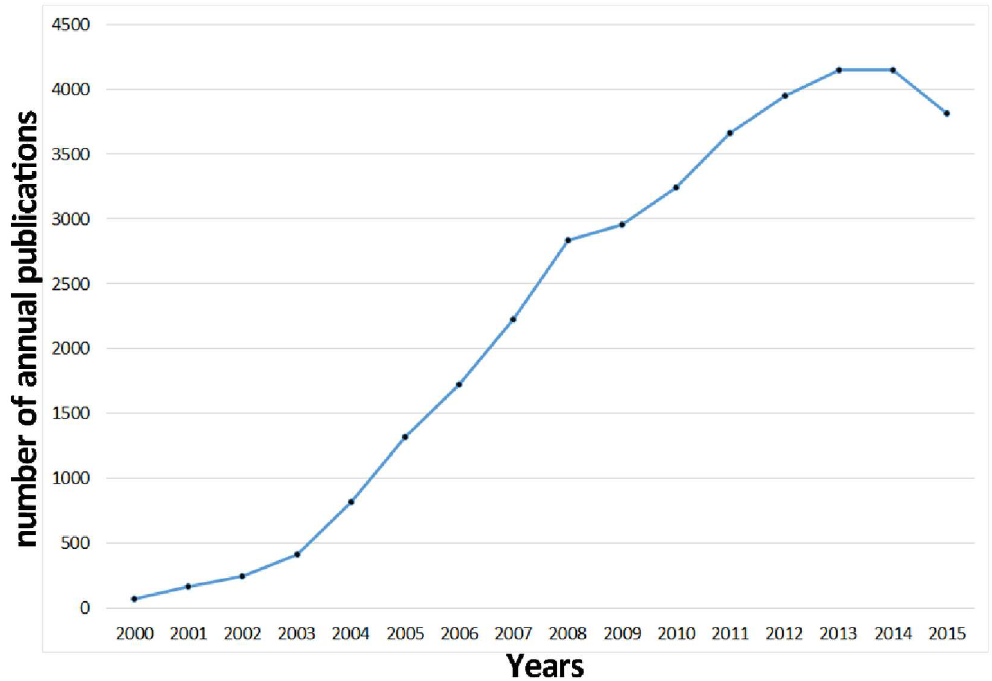
Fig 1. Trends in the number of scholarlypublications relatedto regulatory T cell (Treg) research from 2000 to 2015.